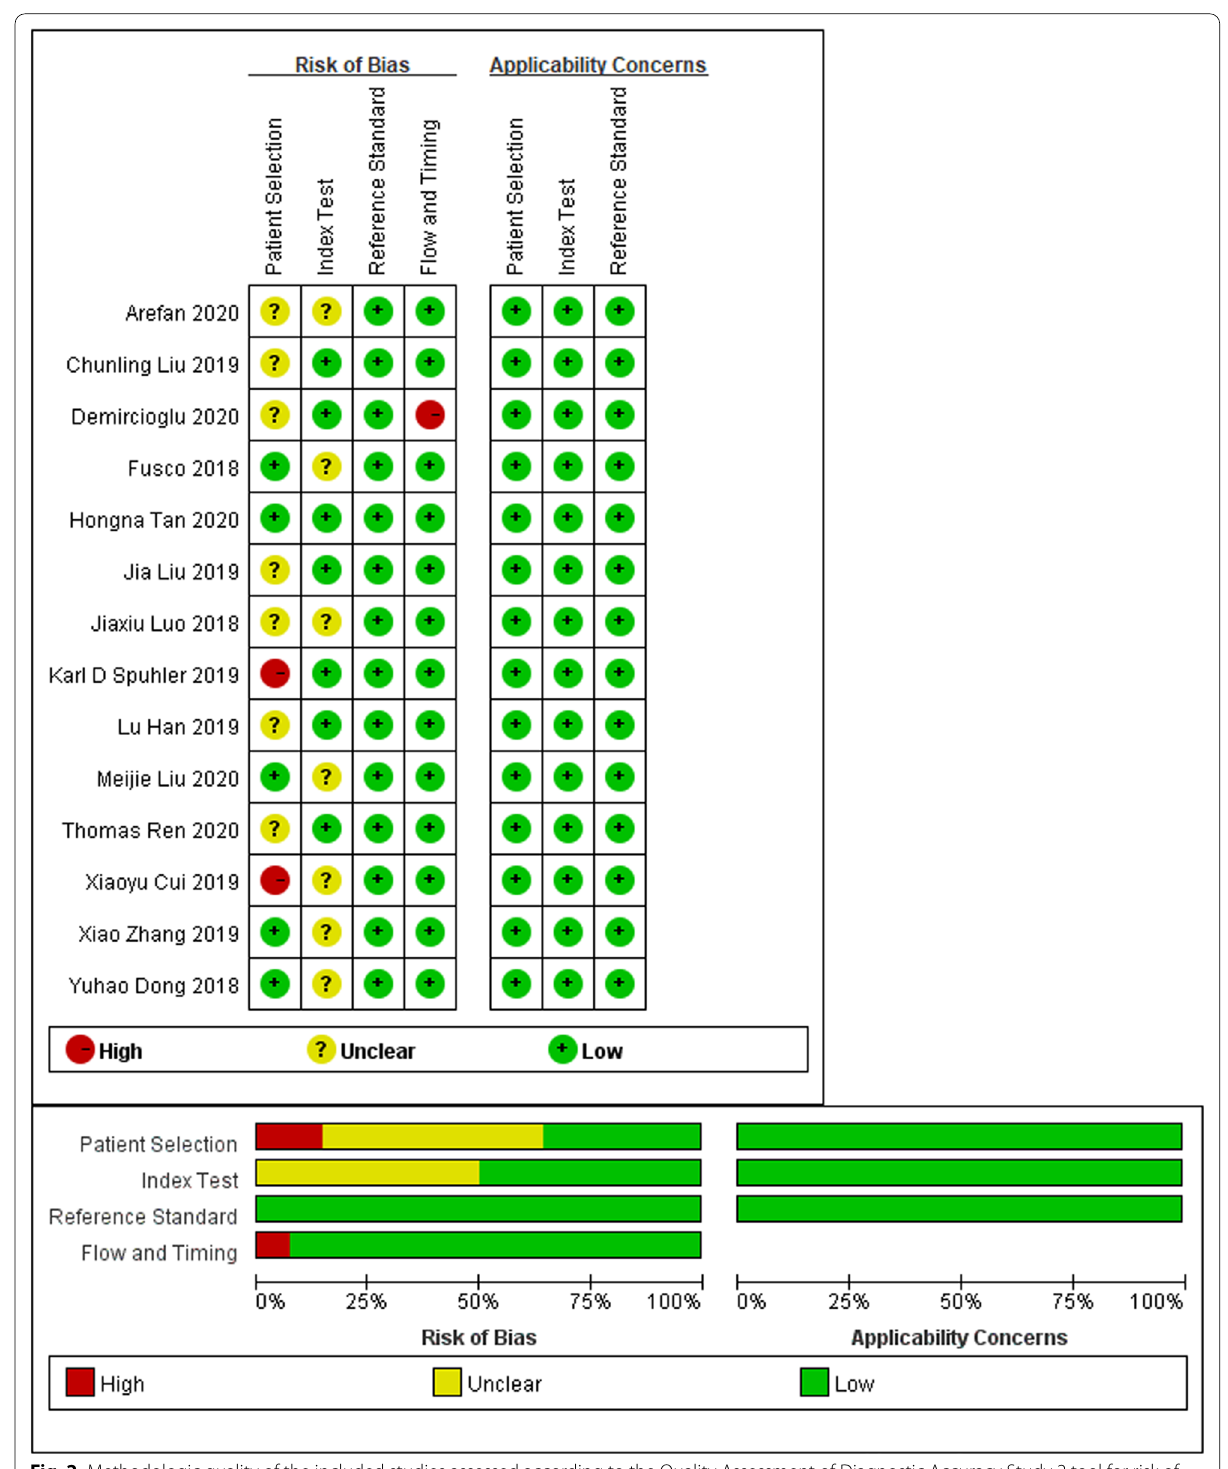
Fig. 2 Methodologic quality of the included studies assessed according to the Quality Assessment of Diagnostic Accuracy Study 2 tool for risk of bias and applicability concerns. Green represents low, yellow unclear, and red high risk of